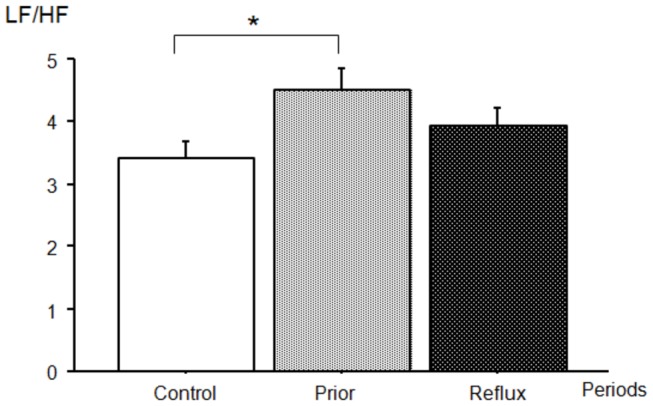
Effect of the period on the sympathovagal balance (LF/HF) (mean ± SEM).*P<0.05. (pairwise multiple comparison procedures were used to test the differences between the control, prior and during periods. Data were adjusted for multiple testing with the Tukey-Kramer test).